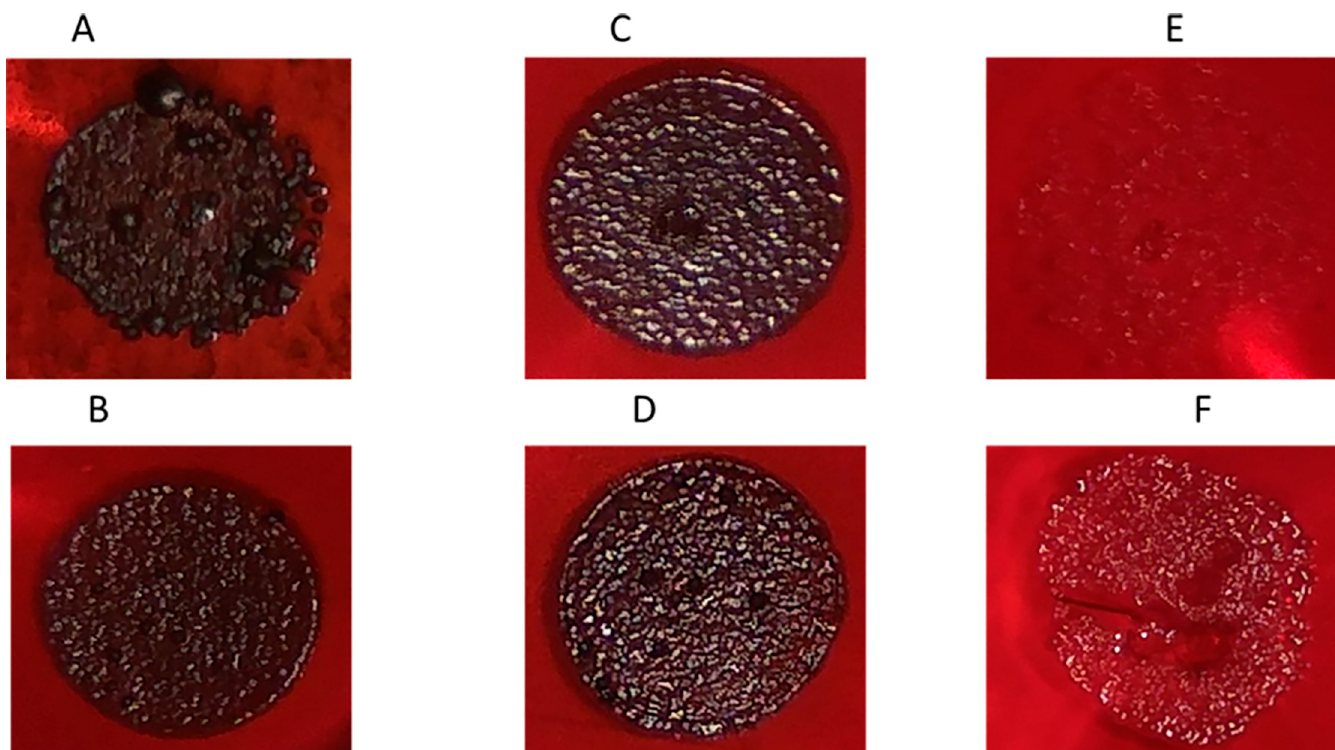
Fig 4. Slime production of MRSA strain 43300. Slime production was observed using CRA plates. (A) Untreated. (B) Treated with single MET. (C) Treated with single AEA. (D) Treated with single AraS. (E) Treated with a combination of AEA and MET. (F) Treated with a combination of AraS and MET.